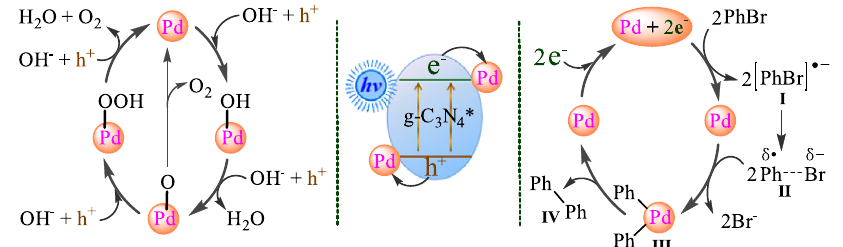
Fig. 10 | Proposed mechanism. Photocatalytic reductive coupling of bromobenzene using Pd/g-C 3 N 4 *. PhBr: bromobenzene, h + : hole, e − :